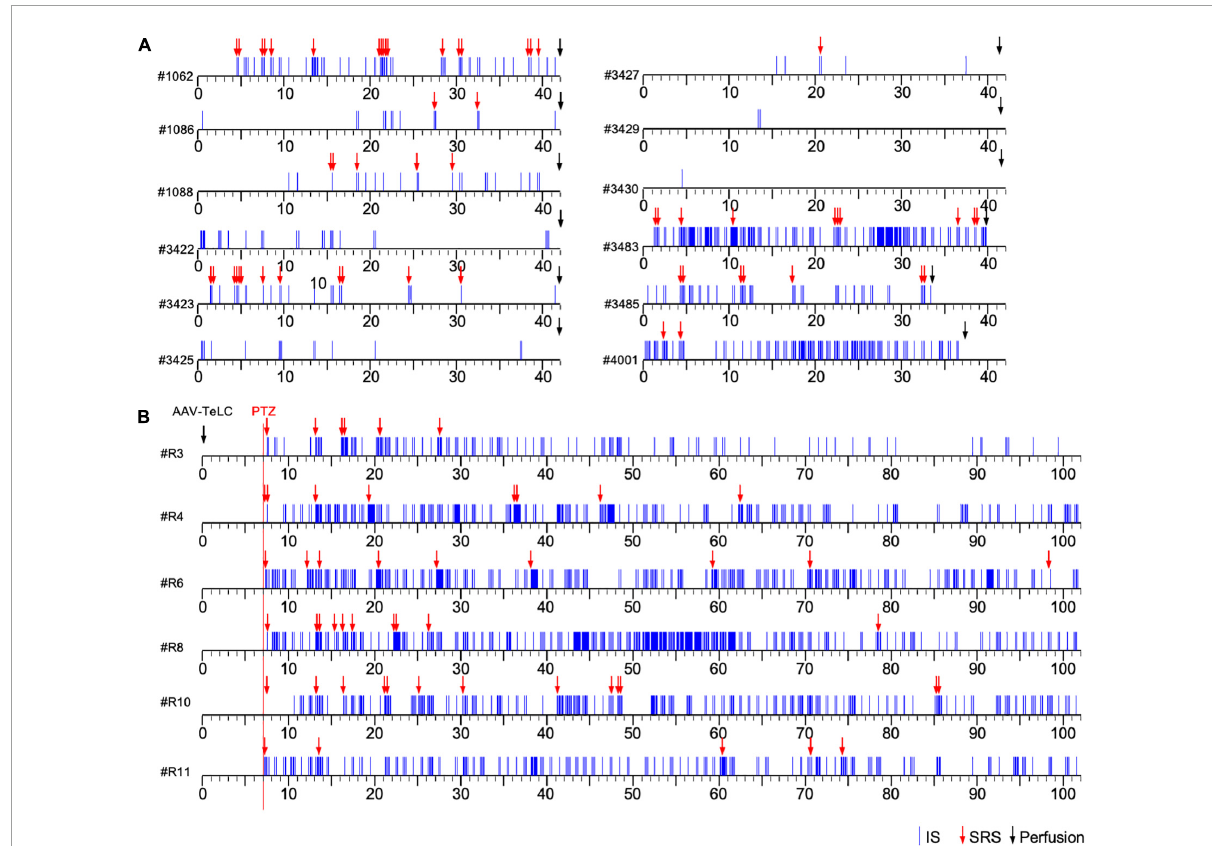
FIGURE1 Development of clusters of interictal spikes (IS) and spontaneous recurrent seizures (SRS) in PV-cre mice after unilateral injection of AAV- TeLC into the ventral subiculum/area CA1. (A) Events of IS clusters (blue lines) and of SRS (red arrows) are listed for twelve representative mice; the respective identification code is shown left to the time scale. Panels (A,B) show the results of Experiments 1 and 2, respectively (see section “Experimental approach”). In contrast to Experiment 1 (A) , in Experiment 2 (B) EEG recordings were started at day seven after vector injection (red vertical line). About 30 min later, mice were injected with a low dose of PTZ (40 mg/kg; red arrows indicate acute PTZ-induced seizures). Besides acute seizures, PTZ induced development of SRS and IS clusters in all AAV- TeLC -injected mice but not in AAV- GFP -injected mice (not shown). In Experiment 1, mice were sacrificed after 42 days (except three mice that lost their electrodes earlier; (A) . In Experiment 2, mice were monitored for 102 days (B) . Both groups of mice were sacrificed immediately after terminating EEG recordings and their brains were processed for NPY-IR. Five AAV- GFP -injected mice were included as controls in each experiment. They developed no SRS or IS clusters (not